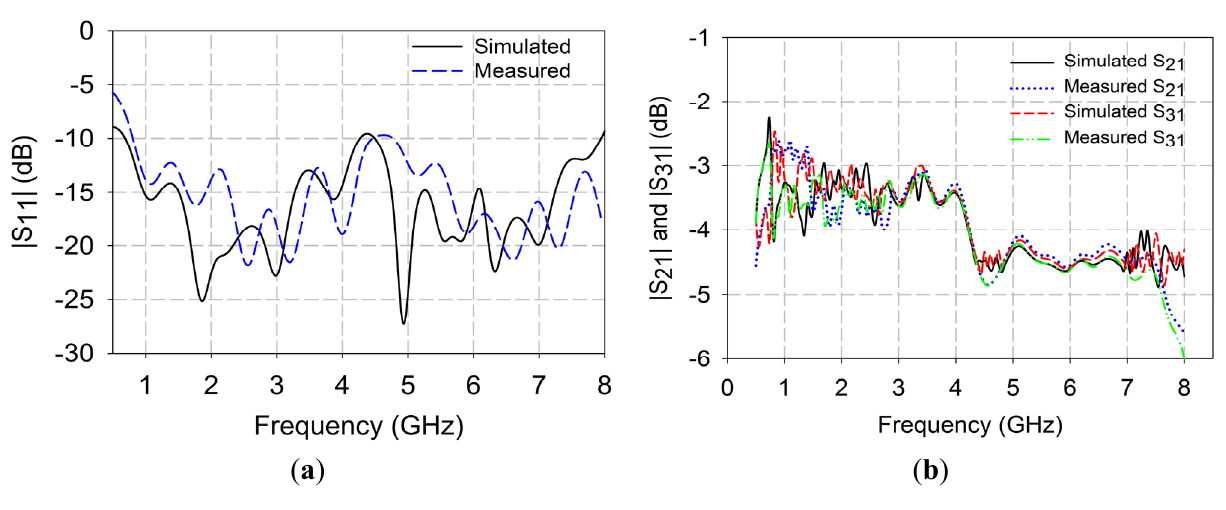
Figure 4. Simulated and measured S-parameters of the proposed balun: ( a ) |S 11 |; and ( b ) |S 21 | and |S 31 |.